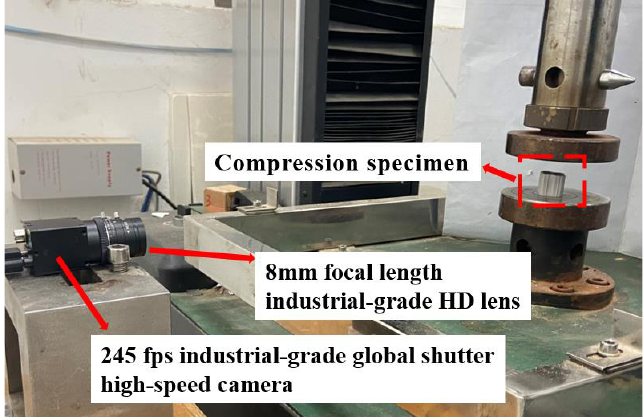
Figure 6. Schematic diagram of the high-speed camera site layout.